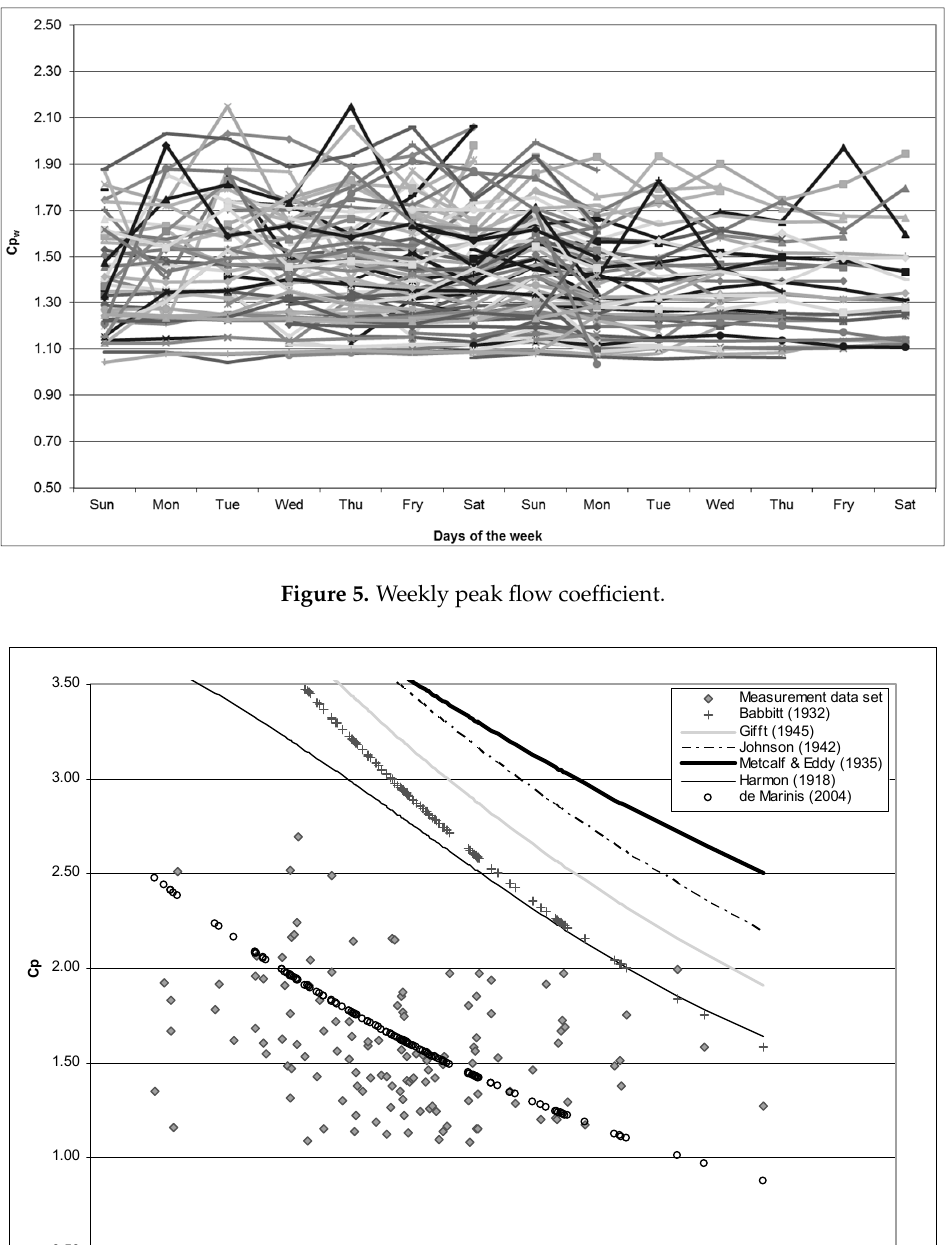
Figure 6. Comparison of experimental data and literature formulas for the corresponding population using a logarithmic scale.